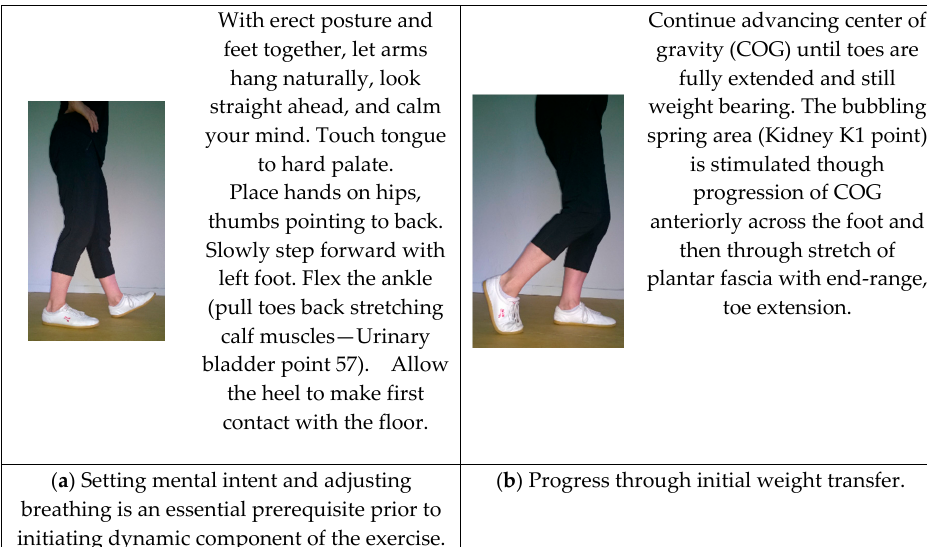
Figure 3. ‘Lotus Leaves Rustle in the Wind’. Intent and purpose of the exercise progression as well as performance instructions are provided within the illustrations.